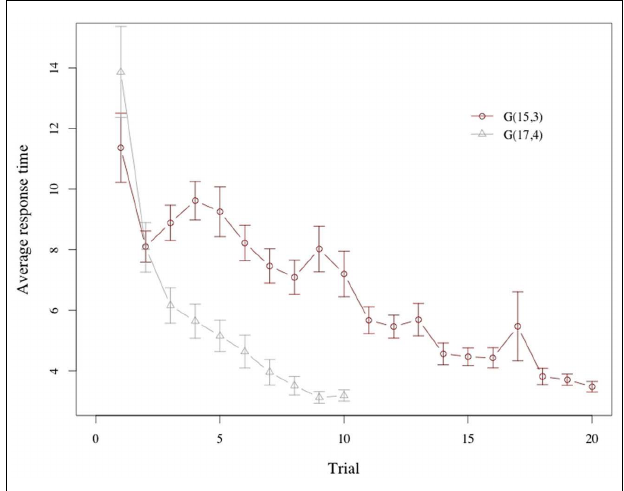
FIGURE 3 | Response time. Average response time across trials in G (15, 3) and G (17, 4).The plot shows an unexpectedly long response time for the